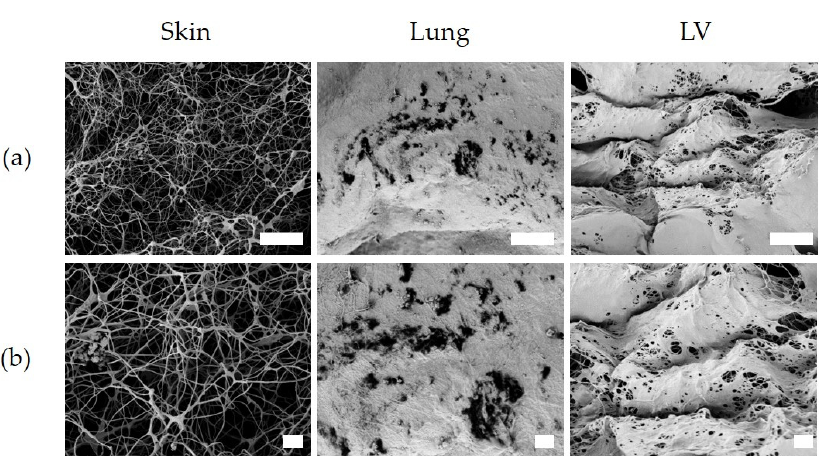
Figure 9. Surface microarchitecture of skin-ECM, lung-ECM and LV-ECM. ( a ) Magnification at 5000 × ; ( b ) Magnification, 10,000 × . Scale bars: 10 ( a ) and 2 µ m ( b